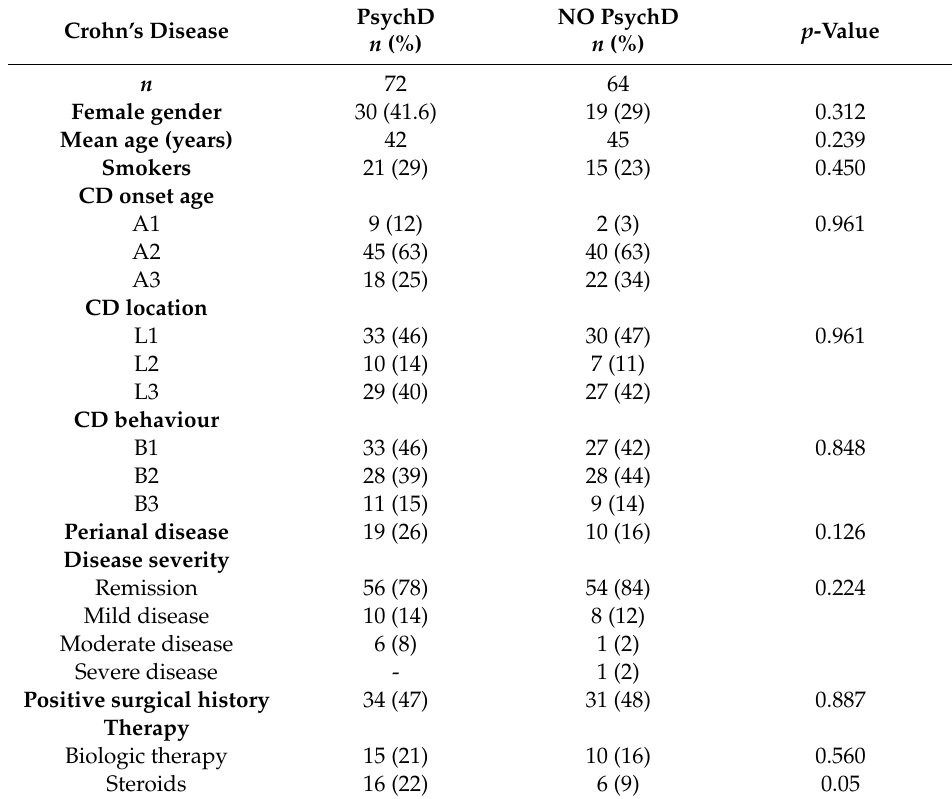
Table 2. Demographic and clinical characteristics of Crohn’s disease (CD) patients with and without any current psychiatric disorders (PsychD).